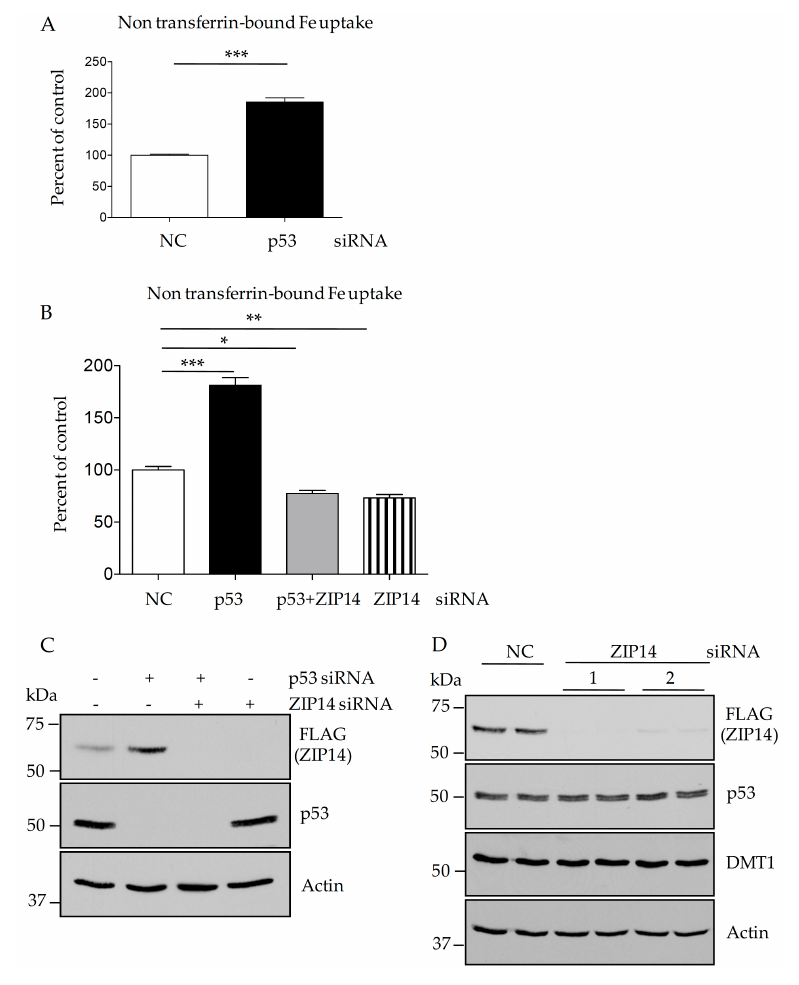
Figure 7. Knockdown of p53 increases iron uptake through elevated ZIP14. HepG2-ZIP14-FLAG